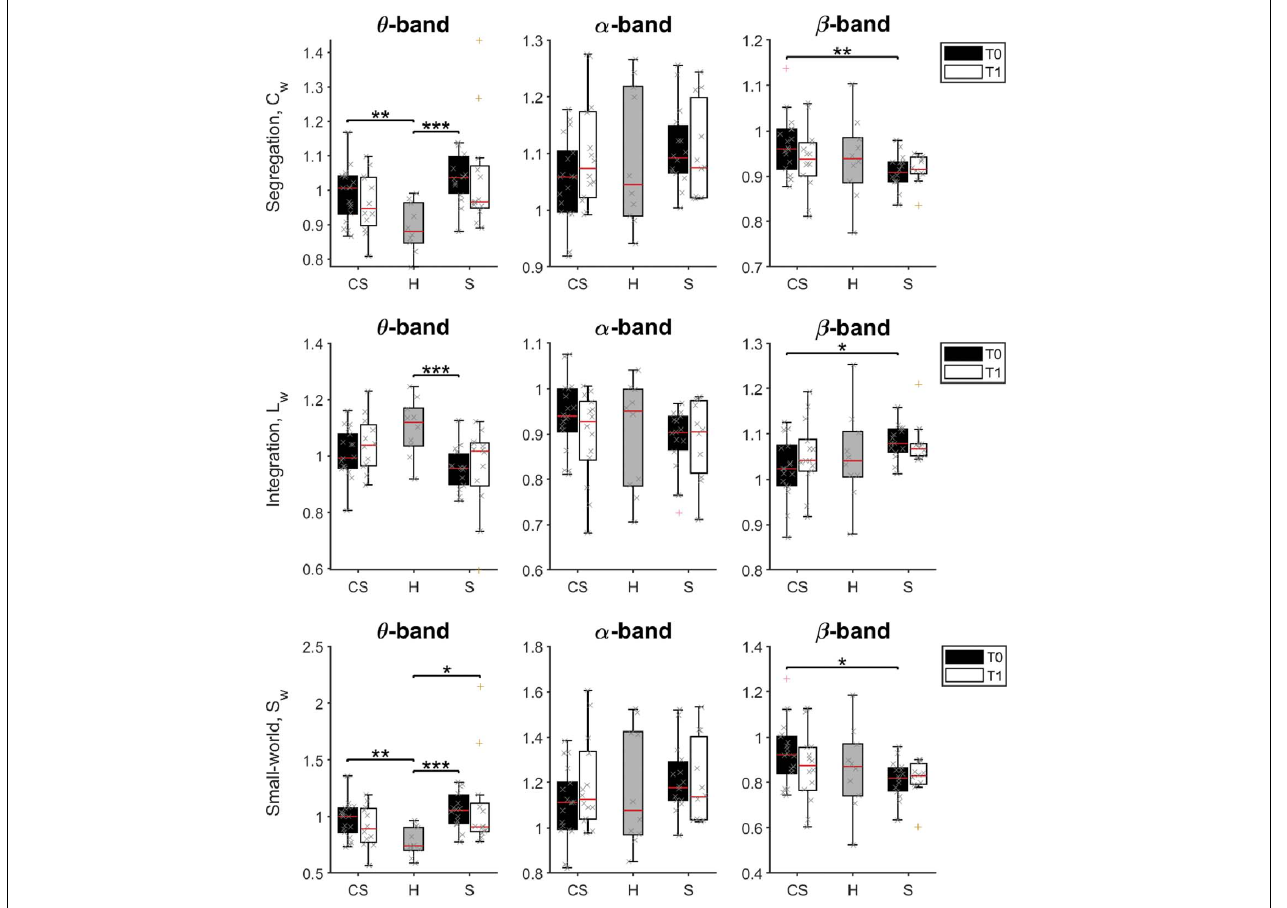
FIGURE 6 | Pairwise comparison of network measures in θ -band (left panels), α -band (middle panels), and β -band (right panels) for cortico-subcortical (CS) patients, subcortical (S) patients and healthy subjects (H). Computed metrics are Weighted Clustering Coefficient (C w ) for network segregation, Weighted Characteristic Path Length (L w ) for network integration, and Weighted Small-Worldness (S w ) for small-world network characteristics. * p < 0.05, ** p < 0.01, *** p < 0.001.